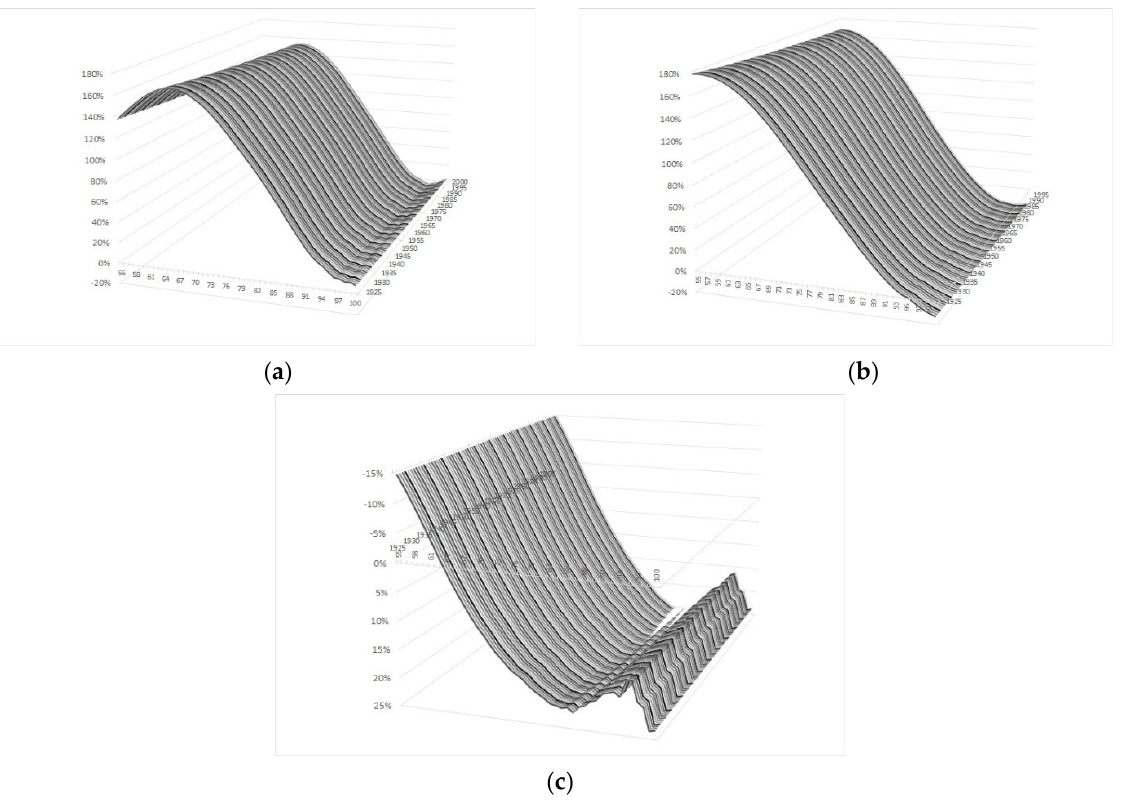
Figure 6. Actuarial equity factor for disability. Percentage of LTC supplement by age and gender. ( a ) Men; ( b ) women; ( c ) effect of gender on the LTC percentage by age. Source: Own work. Software used: Microsoft Excel.